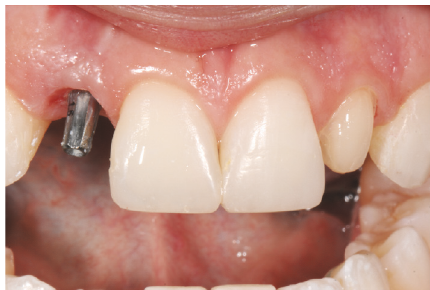
Figure 8: Removal of temporary restorations. Note the absence of soft tissue inflammation, demonstrating adequate adaptation of the provisional restorations with bisacrylic